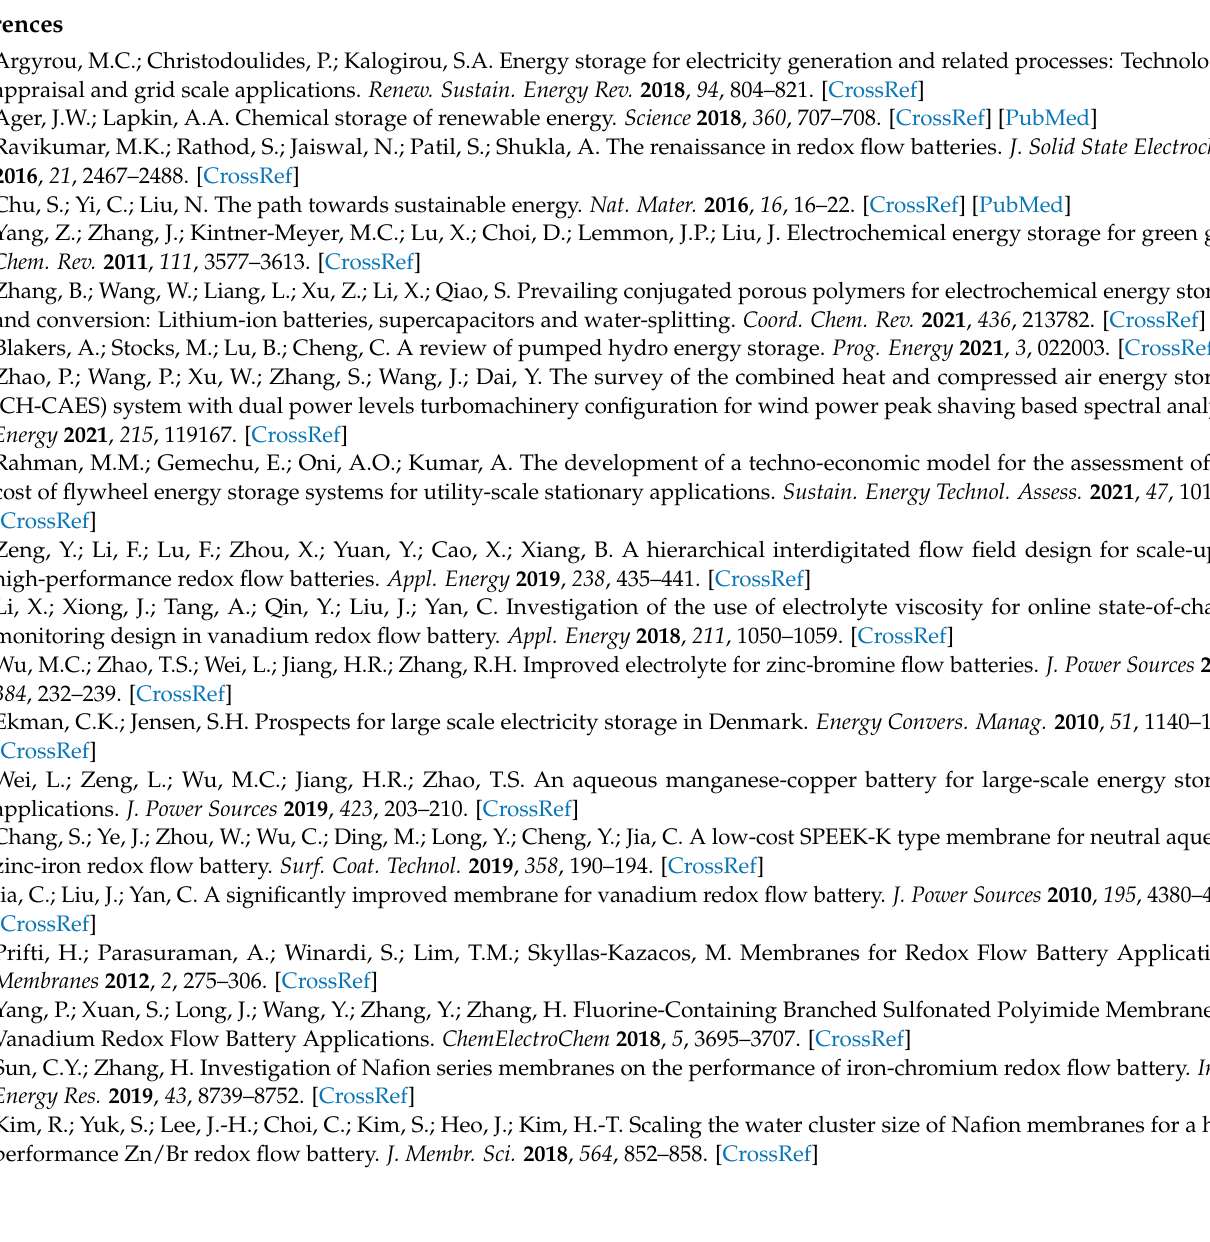
Table S1: Proton conductivity and resistivity of the